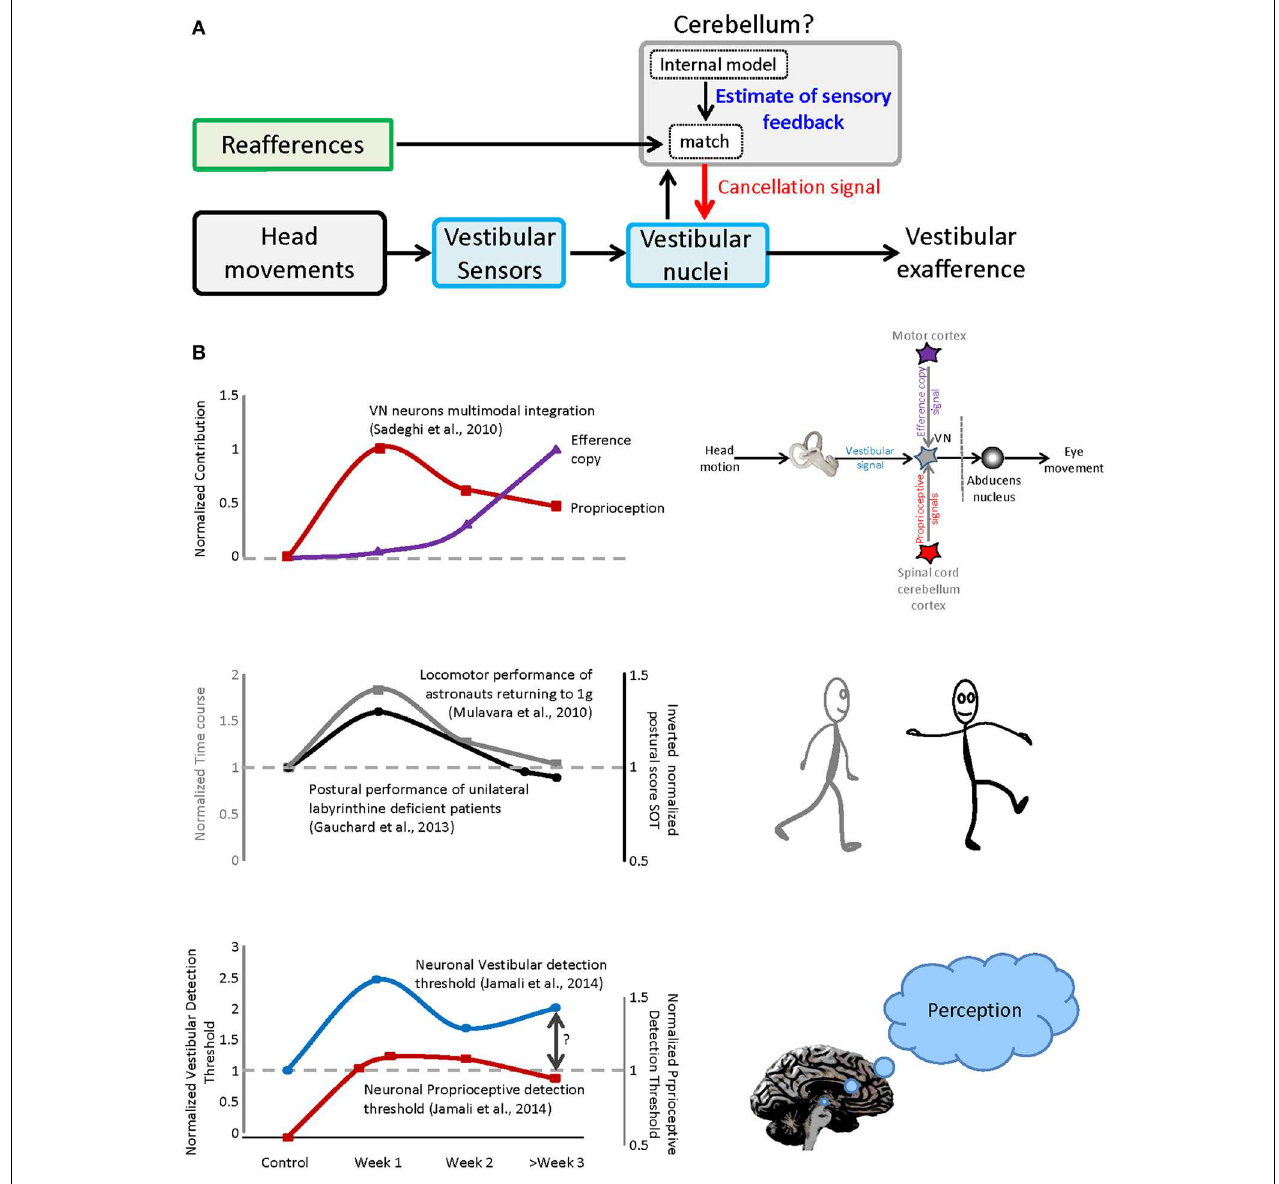
re-weighting of multimodal inputs during vestibular compensation. Middle panel: the time course of the behavioral adaptation for vestibular patients as well as astronauts after re-entry. Bottom panel: the contribution of vestibular and neck inputs to the neuronal detection thresholds over the course of recovery after vestibular loss.